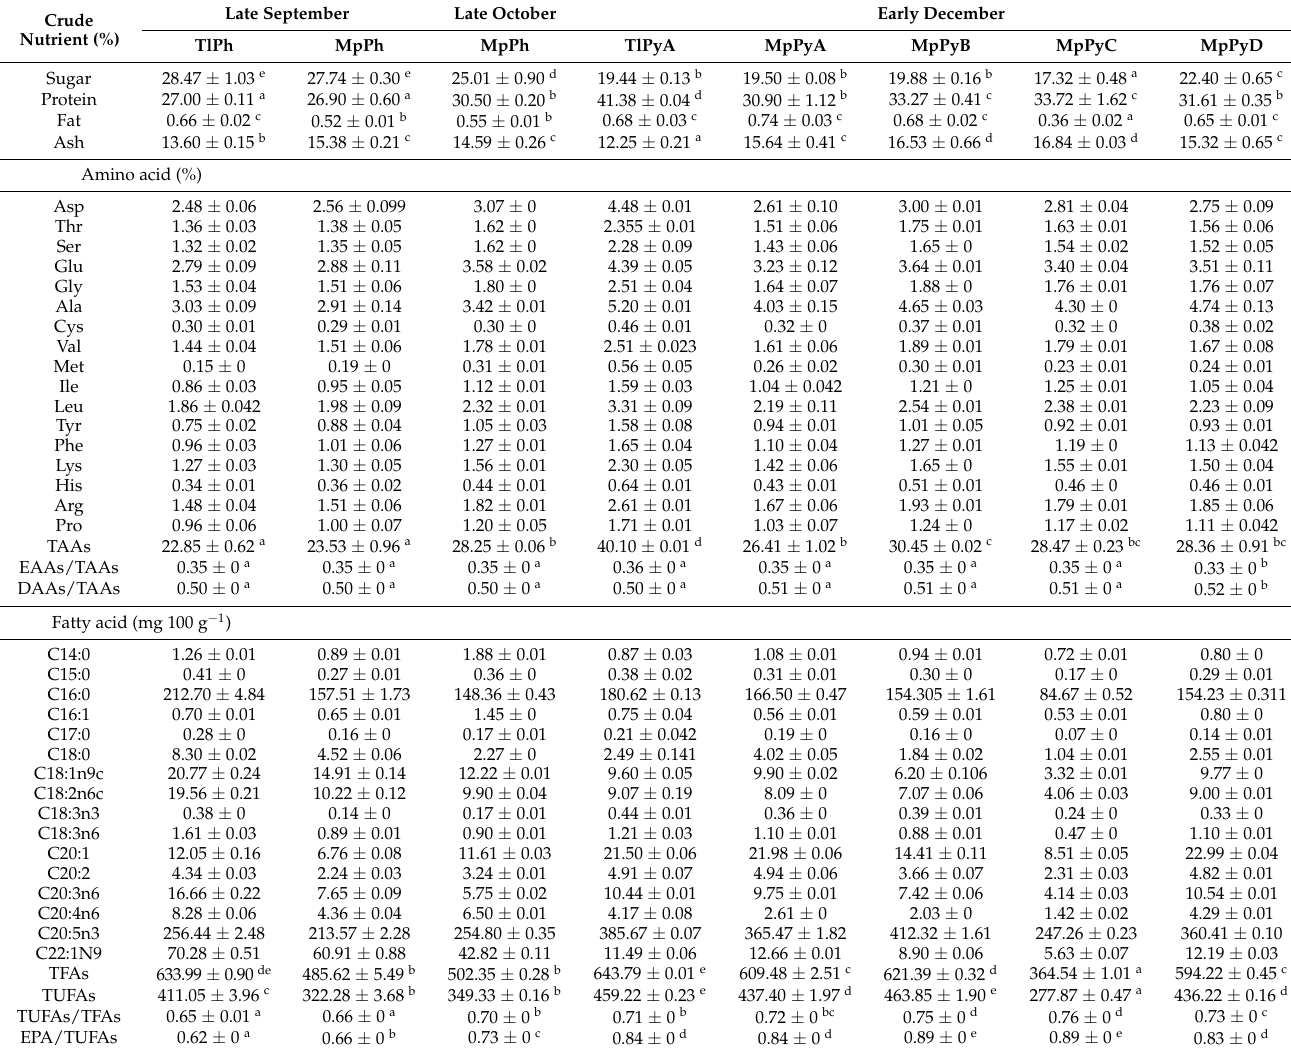
Table 1. The content of total sugar, protein, fat, amino acid and fatty acid in the N. haitanensis and N. yezoensis samples ( n = 3). Data were shown in dry weight (DW). The different letters (a/b/c/d/e) in each row shows that the values are significantly different ( p < 0.05). TlPh— N. haitanensis cultured in Taoluo, MpPh— N. haitanensis cultured in Muping, TlPyA— N. yezoensis strain A cultured in